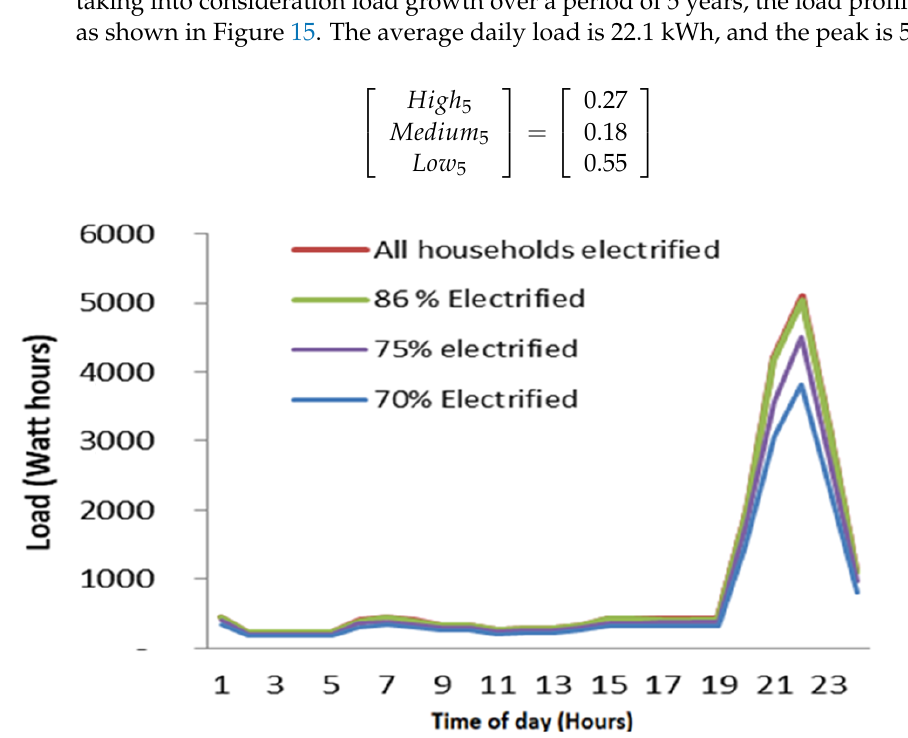
Figure 15. Load profiles for different socio-economic characteristics.